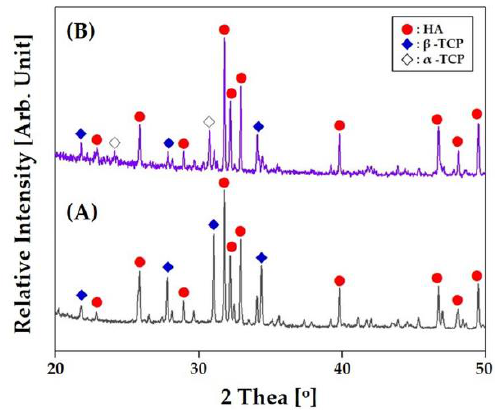
Figure 9. Representative X-ray diffraction (XRD) patterns of ( A ) the CaP powder and ( B ) hierarchically porous CaP scaffold after sintering at 1250 °C for 2 h.